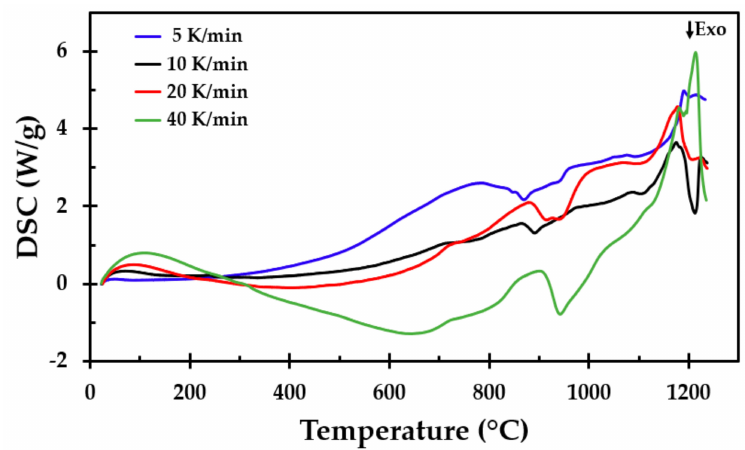
Figure 12. The di ff erential scanning calorimetry (DSC) results as a function of temperature. The minimum and maximum values from the exothermic and endothermic reactions for the three